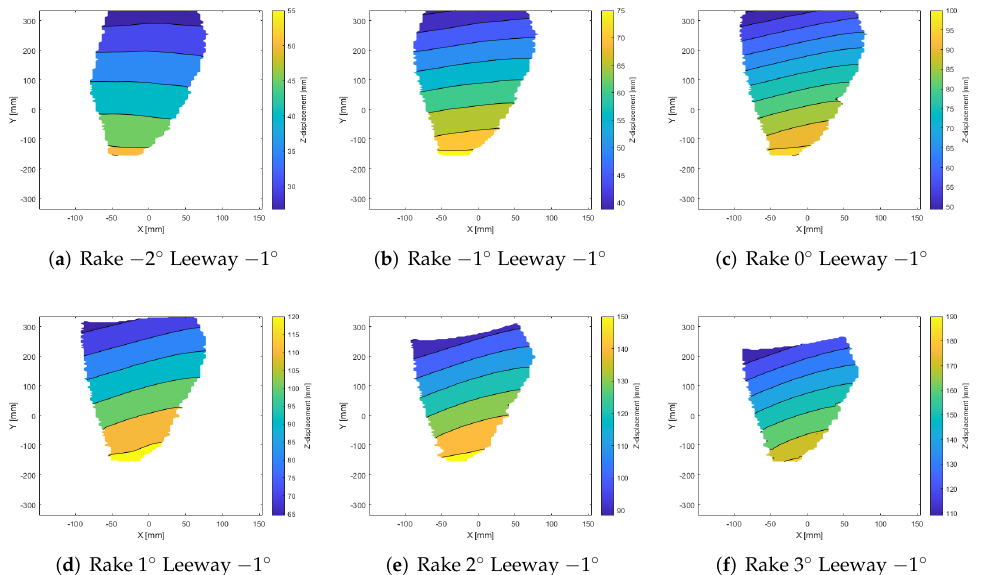
Figure 25. Change in z-deflection for a range of rake angles at a leeway of -1 degrees at flow speed of 7